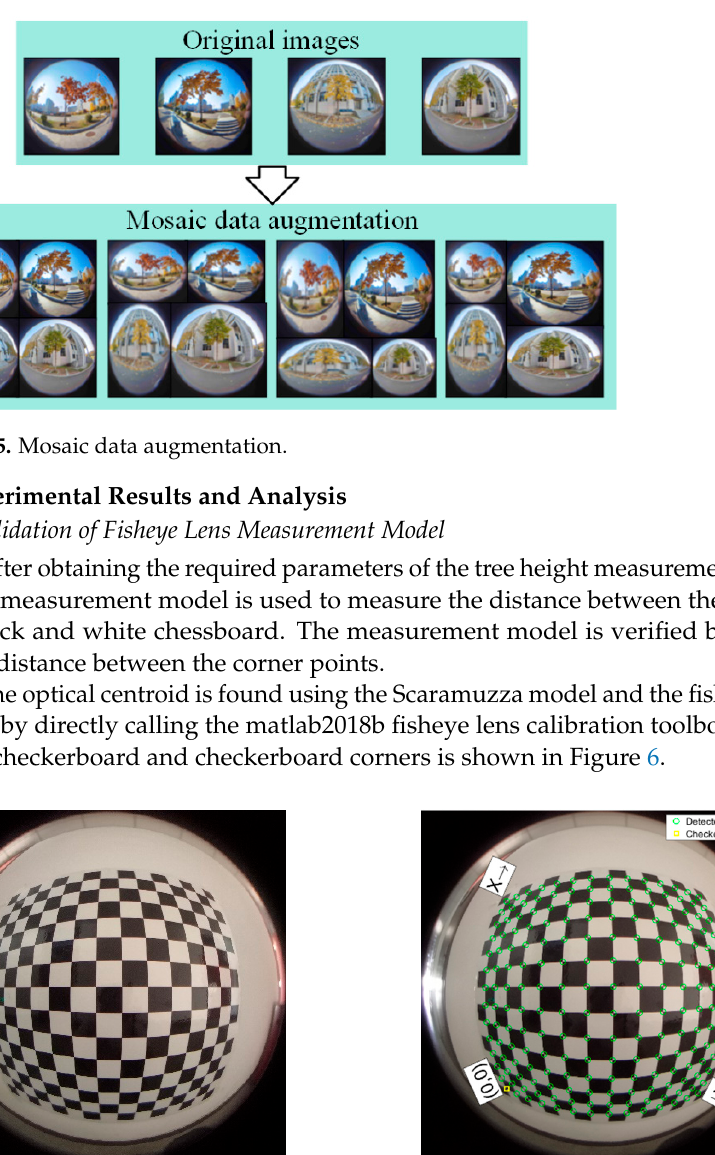
7 of 16 Figure 3. Attention-YOLOX-tiny network structure. Figure 4. Transfer learning.